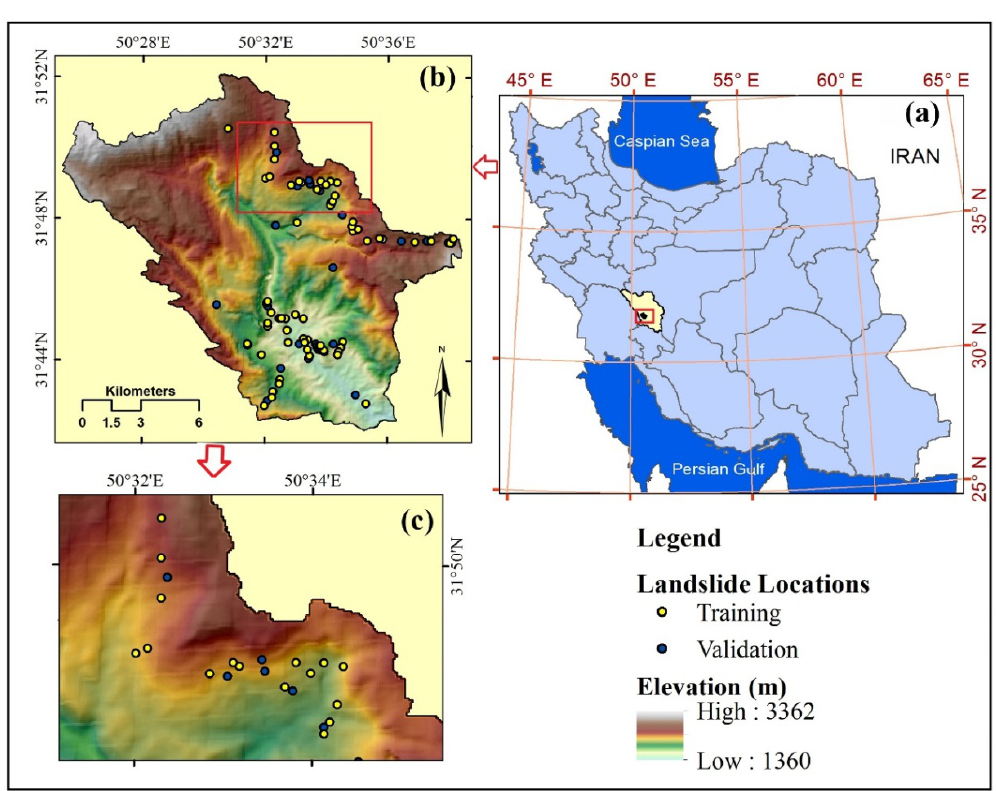
Figure 1. Geographical location of study area: ( a ) Chahar Mahaal and Bakhtiari Province, Iran; ( b ) Sarkhoon watershed; ( c ) locations of some landslides in the watershed.